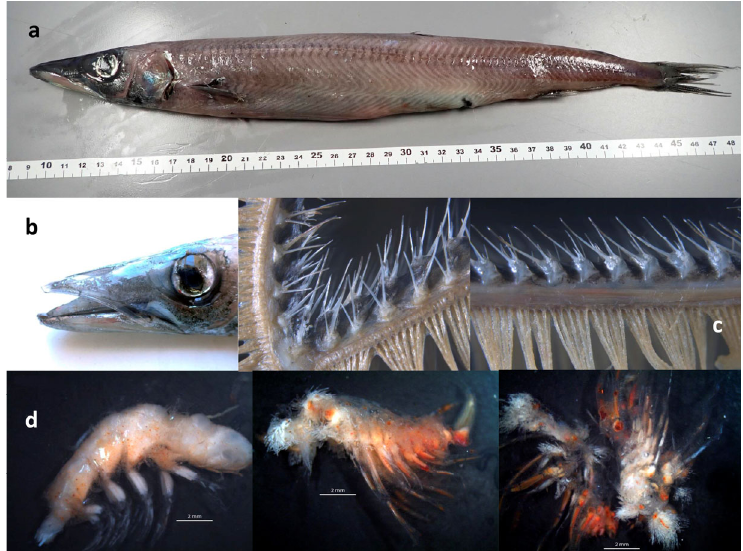
Figure 1. ( a ) Magnisudis atlantica MHN USC 25209, 402 mm TL. ( b ) Detail of mouth and head. ( c ) Detail of the gill rakers showing needle-like teeth. ( d ) Remains of Euphausiids prey